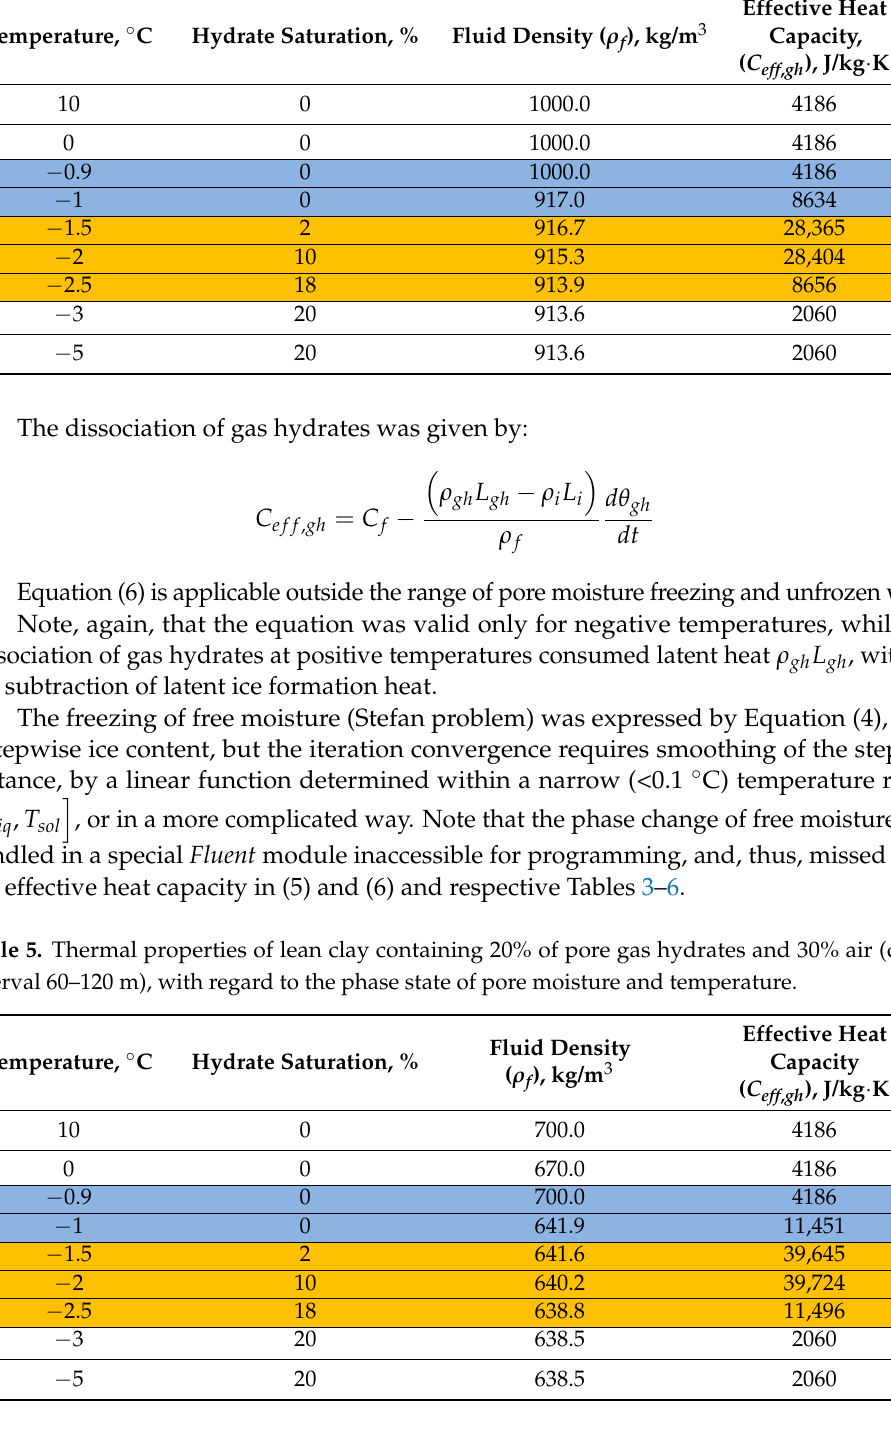
Effective Heat Capacity,